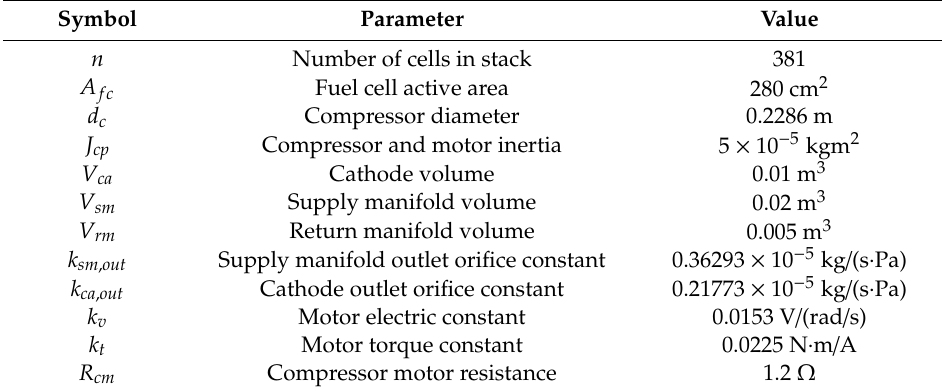
Table 1. Parameters commonly used in the polymer electrolyte membrane (PEM) fuel cell simulator model.